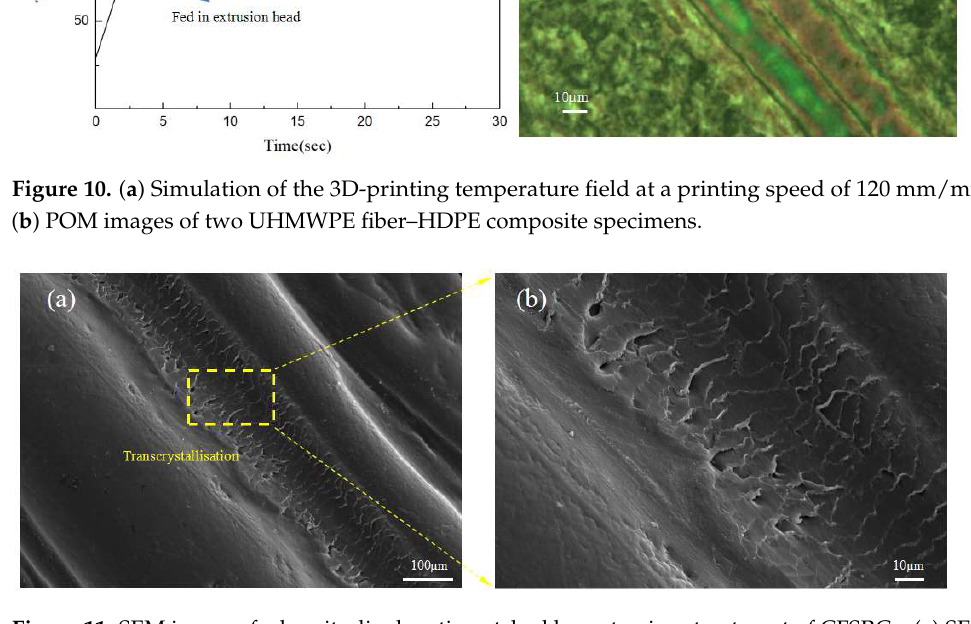
Figure 12b indicates that the UHMWPE fibers were well impregnated into the